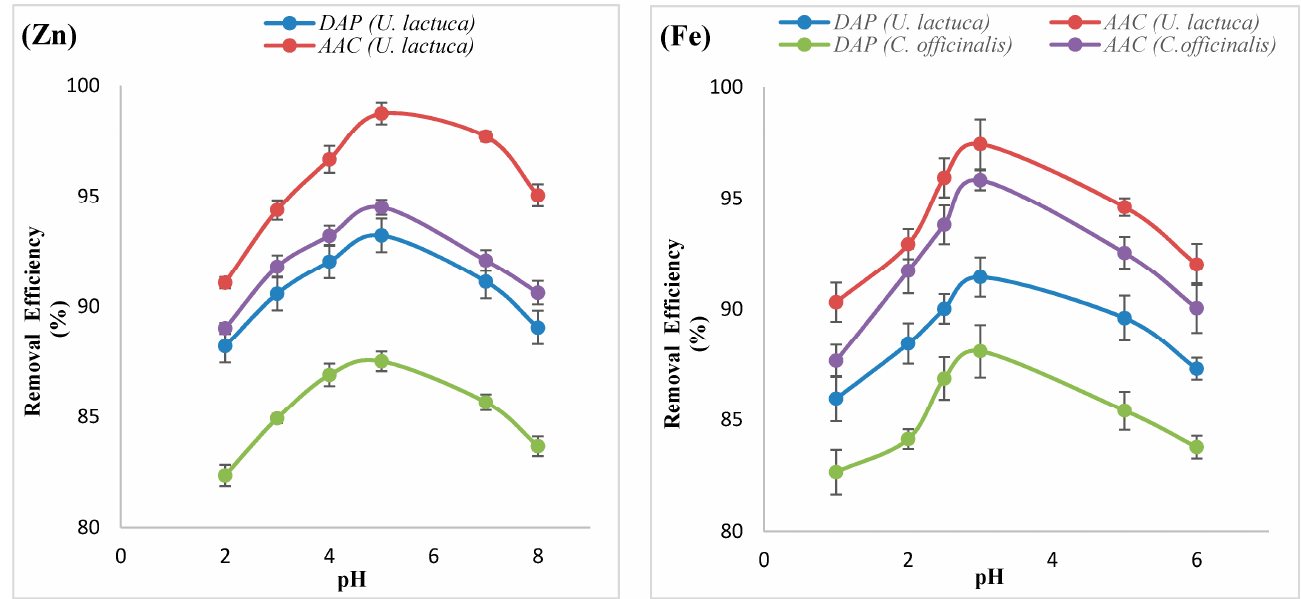
Figure 3. Effect of pH on the percentage of removal of Zn +2 and Fe +3 (at 120 min.by using 50 mg.L − 1 metal-ion concentration and 1.0 g.L − 1 ) using dried algal powder (DAP) and the activated carbon (AAC) of both U. lactuca and C. officinalis. Each data point represents the mean ± SD.